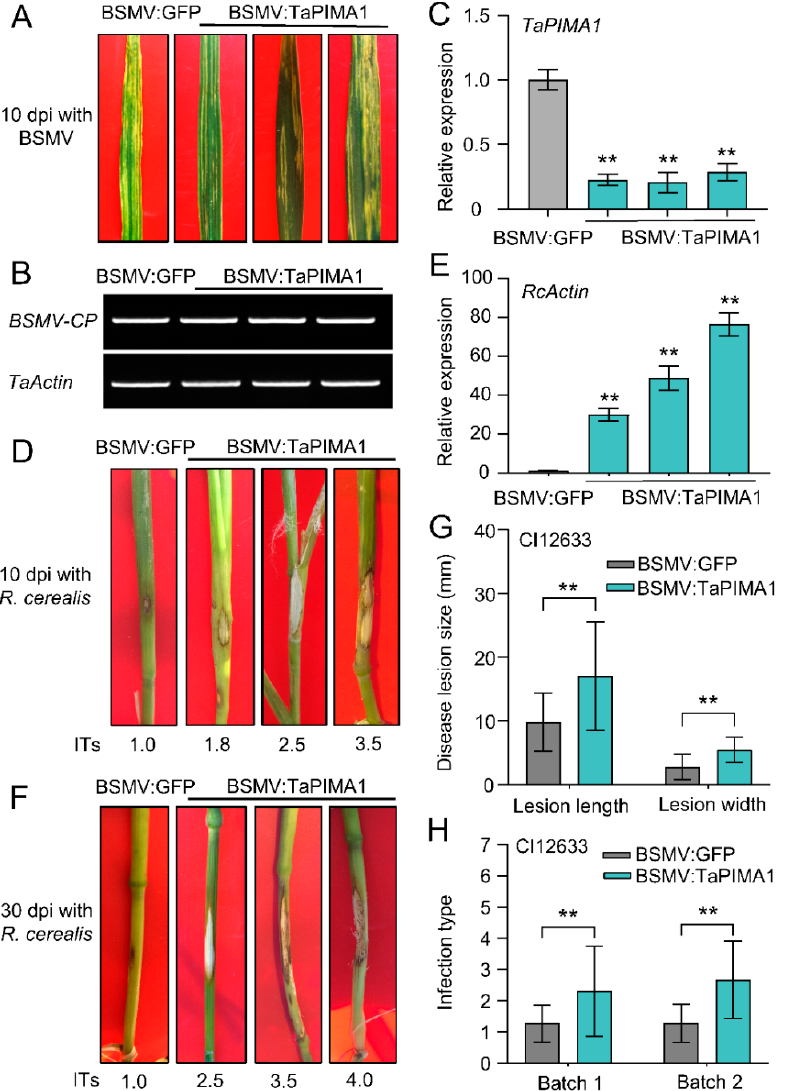
Figure 4. Silencing of TaPIMA1 by BSMV-VIGS reduced resistance to R. cerealis in CI12633 plants. ( A ) The mild chlorotic mosaic symptoms were displayed on the leaves of BSMV-infected CI12633 plants at 10 dpi. ( B ) RT-PCR analysis of BSMV CP in the CI12633 wheat plants. The TaActin (TraesCS5B02G124100.1) was set as an internal control. ( C ) Analysis of the expression of TaPIMA1 in BSMV-infected CI12633 plants by qRT-PCR at 10 dpi. The sharp eyespot symptoms on stems of BSMV-infected CI12633 plants at 10 ( D ) and 30 ( F ) dpi with R. cerealis . Disease severity was indicated by infection types (ITs). ( E ) qRT-PCR analysis of the biomass of R. cerealis in BSMV-infected CI12633 plants. ( G ) Disease lesion size of R. cerealis in TaPIMA1 -silencing and control CI12633 plants at 30 dpi. The lesion length and width represent the lesion size of sharp eyespot. ( H ) The ITs of the BSMV-infected CI12633 plants in two batches. dpi, days post inoculation. The significant differences determined by one-way ANOVA (** p < 0.01). Error bars indicates standard